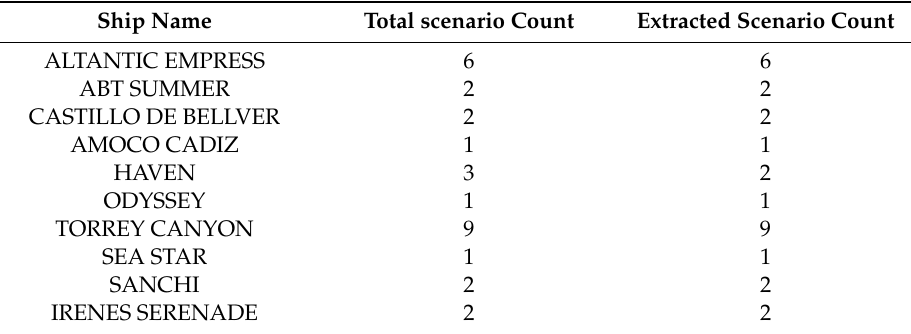
Table 6. Event splitting